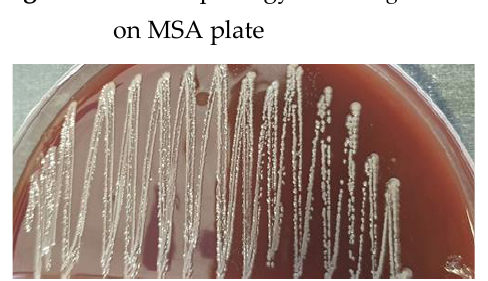
Figure 6: Alpha hemolytic result of S.sanguinis Figure 7: Negative result of catalase test for on blood agar